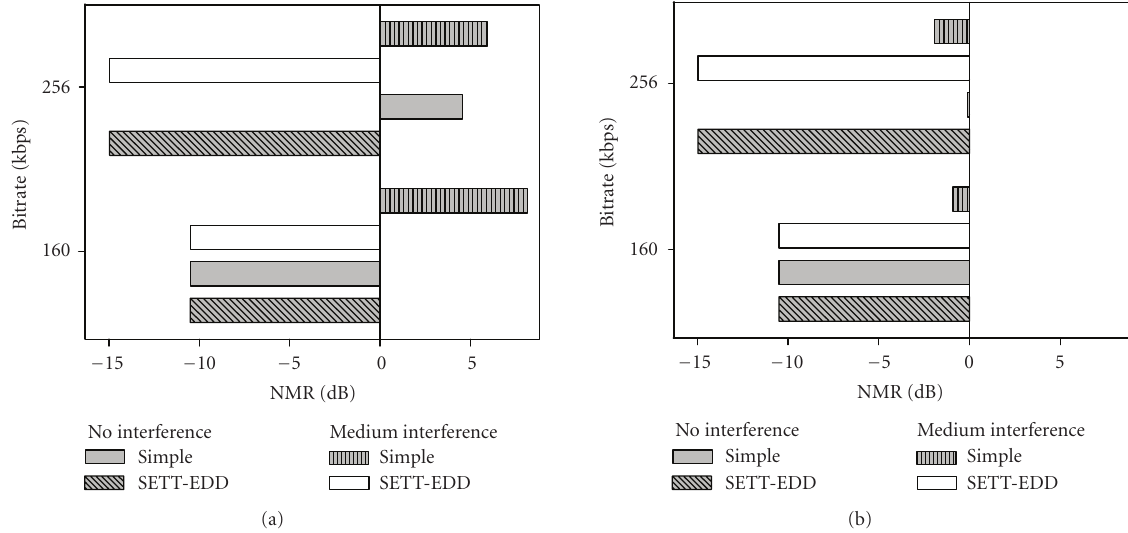
Figure 10: NMR values for MPEG-1 Layer III audio streaming delivery: (a) CoDeS disabled; (b) CoDeS enabled.